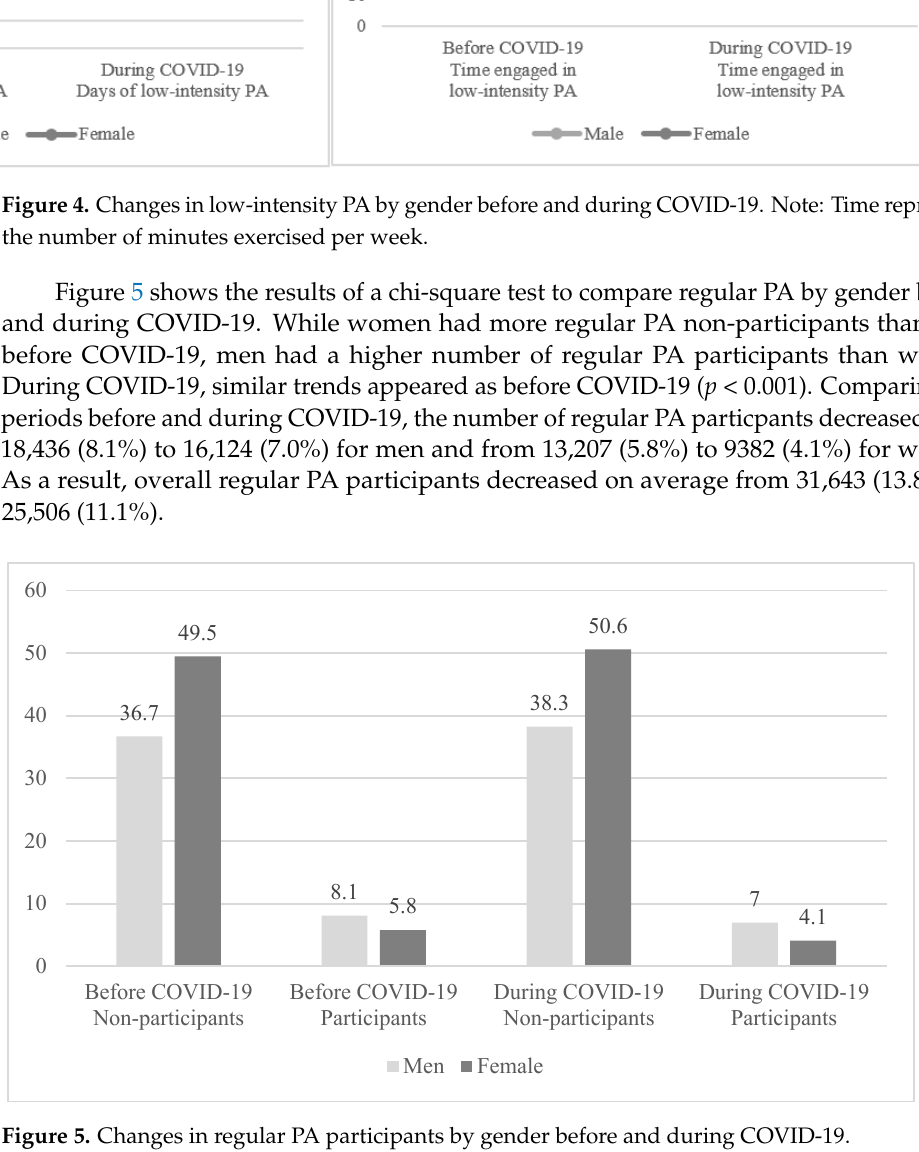
Table 2. Changes in stress by gender and regular PA before and during COVID-19. Variables